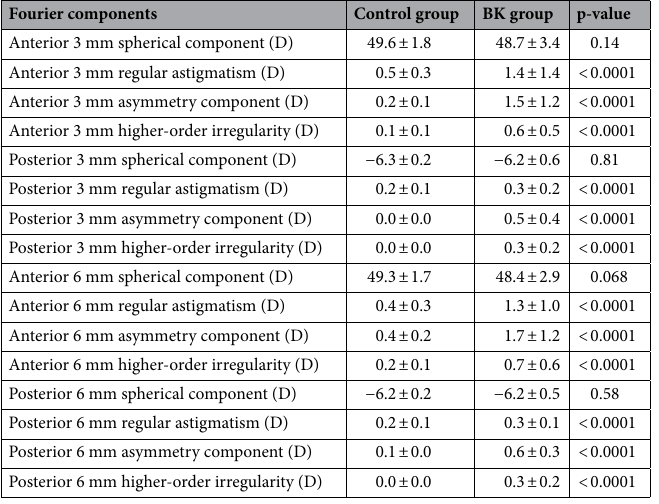
Table 2. Components of the Fourier harmonic analysis for the central 3 mm and 6 mm zones in control and BK